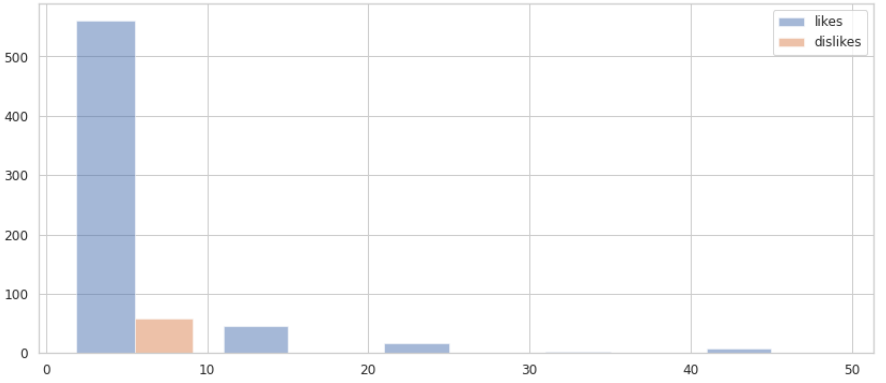
Figure 12. Histogram of likes and dislikes reactions on Odysee